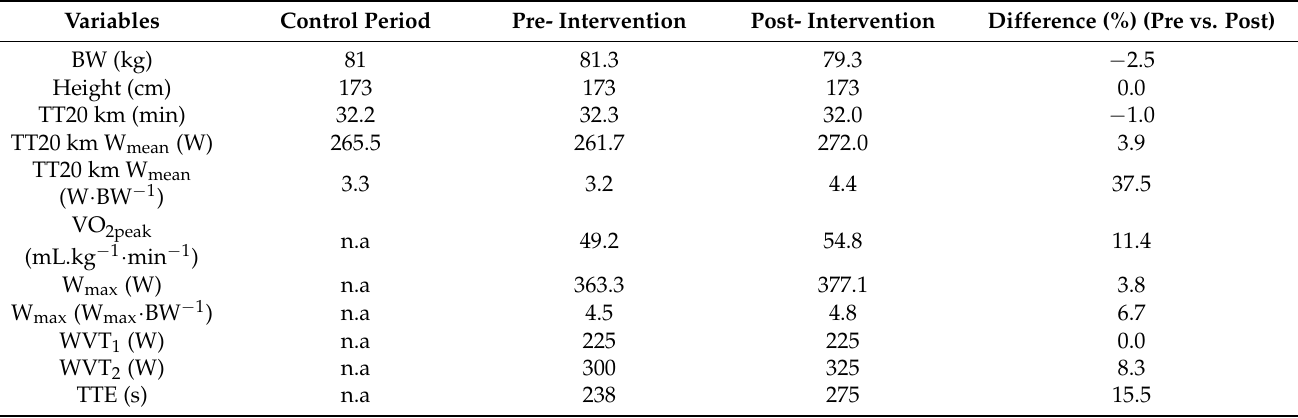
Table 1. Male cyclist anthropometrical, physiological and performance